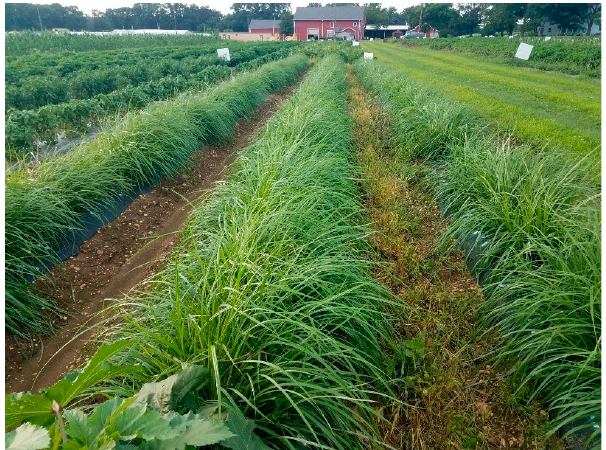
Figure 7. Tigernut growth under black plastic mulch at 10 weeks after transplanting at Horticulture Farm 3, East Brunswick, NJ (Photo: Albert Ayeni).